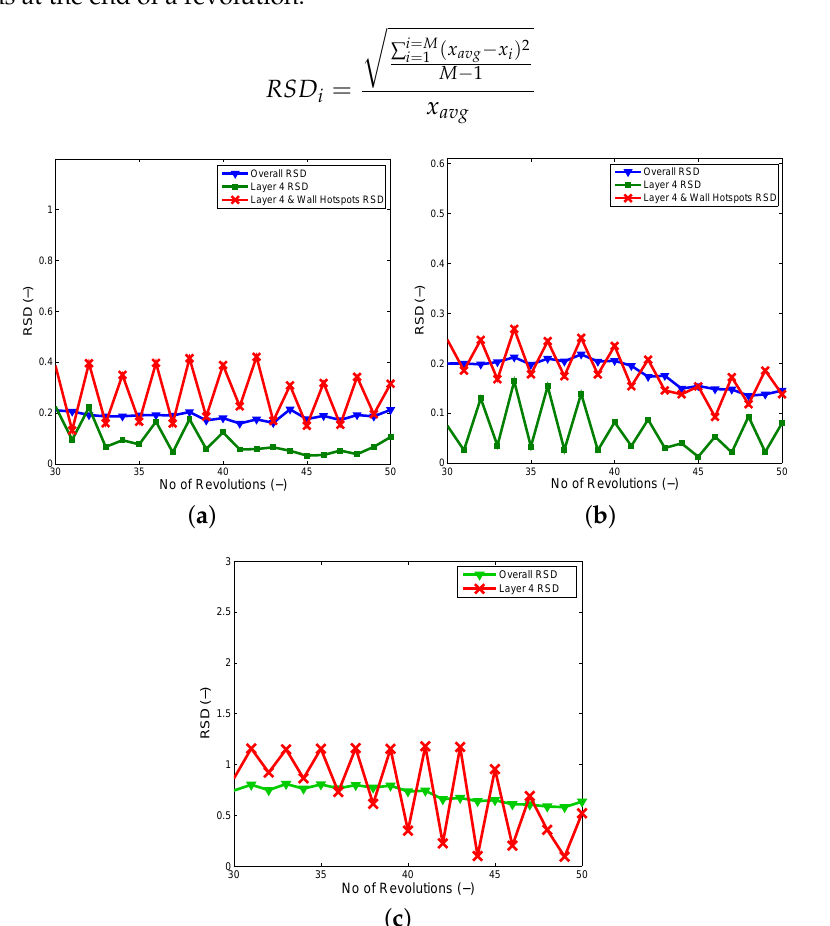
Figure 5. Comparison of the RSD between Layer 4 and the overall RSD for: ( a ) API 1; ( b ) API 2; ( c ) extra granular